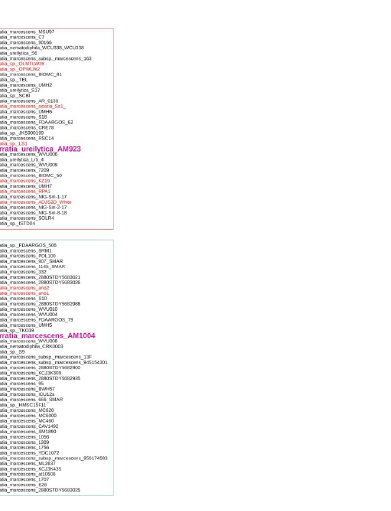
Fig 4. Phylogenetic analysis of concatenated alignments of 14 housekeeping genes from 616 genomes of the genus Serratia . Panel A: mid-rooted tree built from 322 non-identical sequences, including 256 S . marcescens , S . nematodiphila and S . ureilytica isolates, with RAxML and the GTR + Gamma substitution model. Bootstrap support values were inferred from 100 replicates and represented by branch thickness on the complete tree. Branches are drawn to scale and colour-coded according to the clade: red, clade A; brown-green, clade B; blue, clade C. Nodes are colour-coded according to the origin of the strain. Insets showing the groups containing the Melbourne Zoo isolates AM923 (Panel B) and AM1004 (Panel C) with bootstrap support values > 50% indicated on the branches. The scale bars indicate the number of substitutions per site.